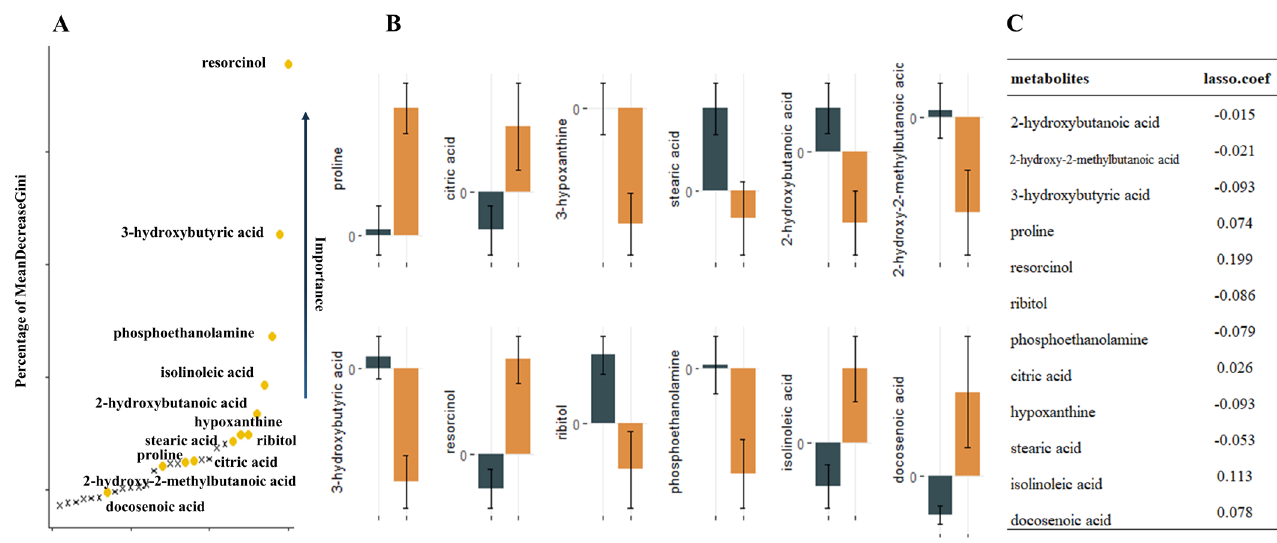
Figure 2. 12 metabolites extracted by the three methods repeatedly. ( A ). Illustration of a random forest graph. The graph shows the top thirty metabolites, the vertical axis shows the proportion of metabolite Gini coefficient reduction among all metabolites, and the metabolites extracted repeatedly with Lasso and t -test are marked in yellow. ( B ). Error bars of metabolite relative concentrations. ( C ). Correspondence coefficients of Lasso extraction features.